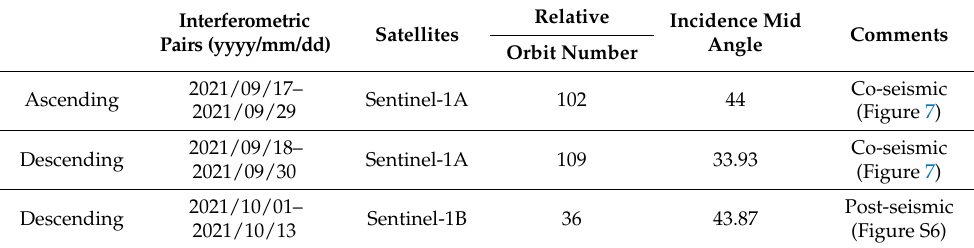
Table 2. Characteristics of the interferometric pairs of Sentinel-1 data that were used in this